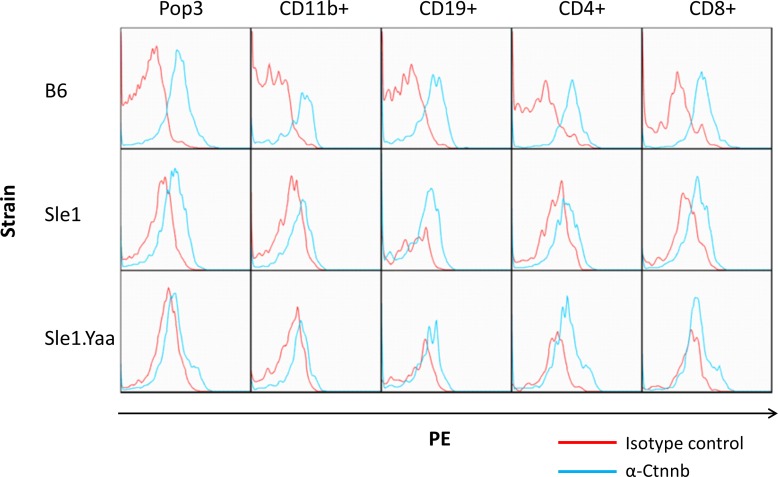
Lupus-prone CD11b+ splenocytes express reduced β-catenin.Splenocytes were extracted from 8-month-old healthy B6, lupus-prone B6.Sle1, and lupus-prone B6.Sle1.Yaa mice and analyzed by flow cytometry for intracellular β-catenin (blue) versus isotype control staining (red). Representative plots shown. Pop3 represents total live cells. CD11b+ cell β-catenin was significantly lower in lupus-prone splenocytes versus healthy controls (by MFI ratios, p = 0.0476).